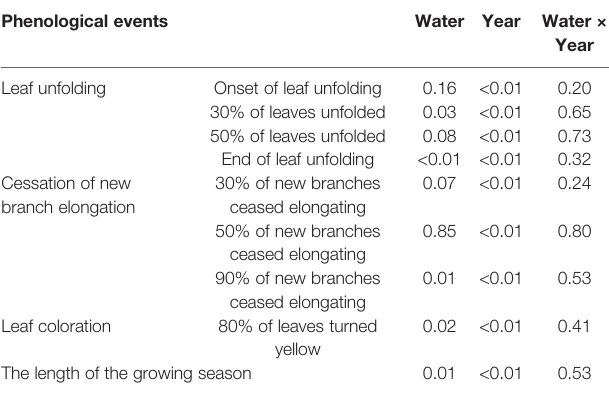
TABLE 3 | Results ( P -values) of Linear Mixed Model (MIXMOD) analysis on the fi xed effects of water addition treatments (water), year, and their interactions on the phenological events and the length of the growing season from 2012 –